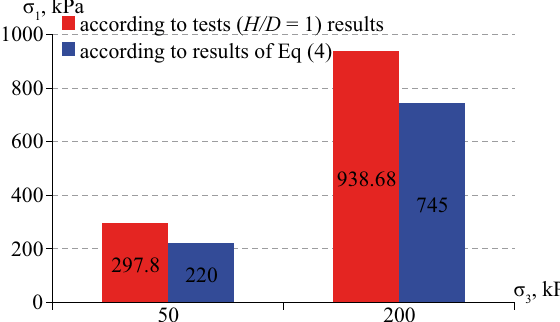
Fig. 12. Relationship of principal stresses σ 1 versus σ 3 at the critical state for dense sand ( e = 0.51